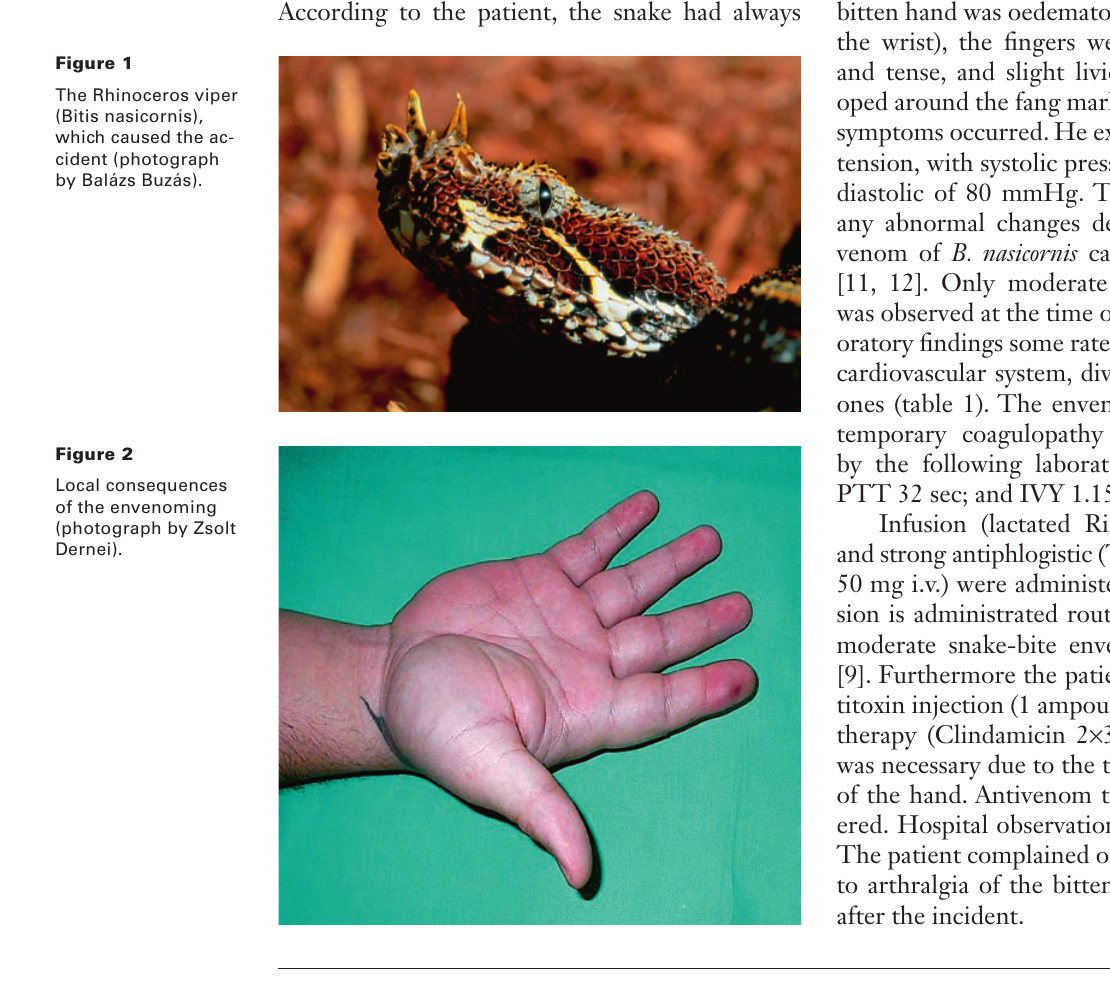
The Rhinoceros viper (Bitis nasicornis), which caused the ac- cident (photograph by Balázs Buzás).